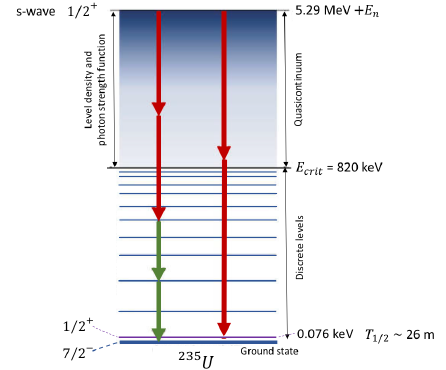
Figure 4. Schema of Monte Carlo cascades generation with diceboxc code. Red arrows depict the transitions generated in terms of LD and PSFs, green arows are the transitions among discrete levels taken from spectroscopic